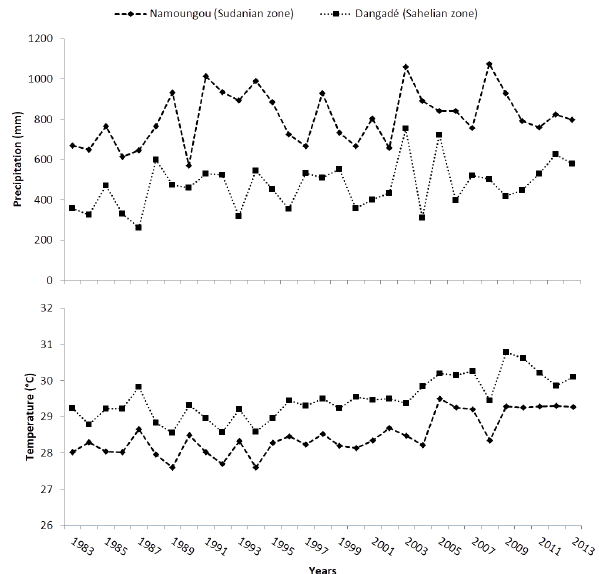
Figure 2. Mean rainfall (mm) and mean temperatures record ( ◦ C) for the weather station of Dori (Sahelian zone) and Fada N’Gourma (Sudanian zone), near the experimental sites, between 1983 and